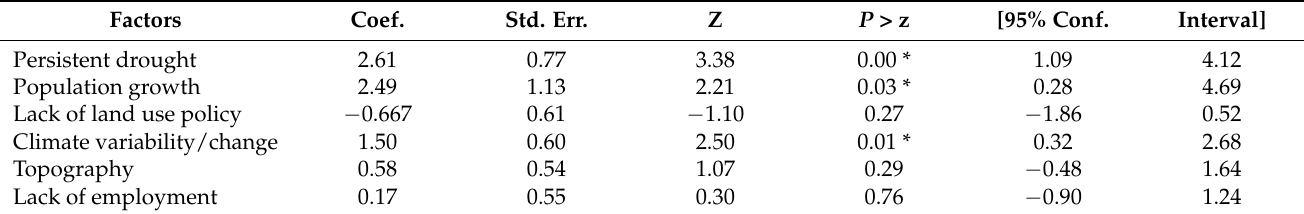
Table 7. Underlying driving forces of